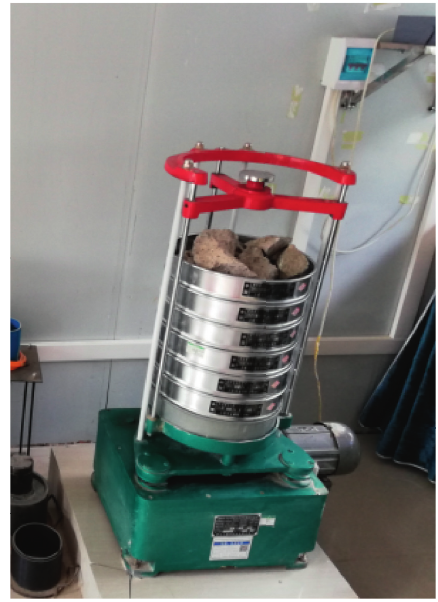
Figure 11: ZBSX-92A shock-type dual-purpose pendulum screening machine.